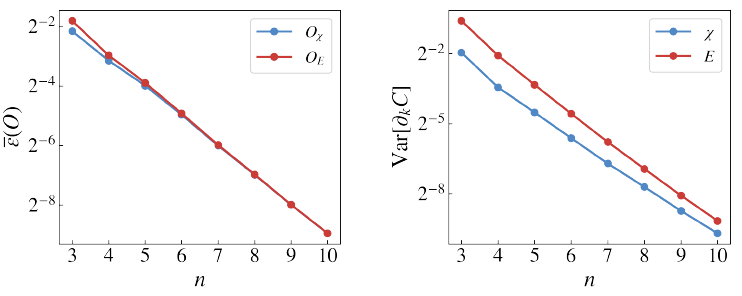
Figure 2 . (Left) Plot of ε ( O ) defined in eq. (3.1) against qubit number n for O ∈ { O E , O χ } . For both values of O , ε ( O ) decays exponentially when n is sufficiently large. (Right) Sample plot of the variance Var θ ,V [ ∂ ( k ) C ] where C ∈ { χ, E } and D = d = 2 . We use 5000 Haar random unitaries to i empirically compute ε ( O ) and the variance. Both variance plots approach exponential decay when n is sufficiently